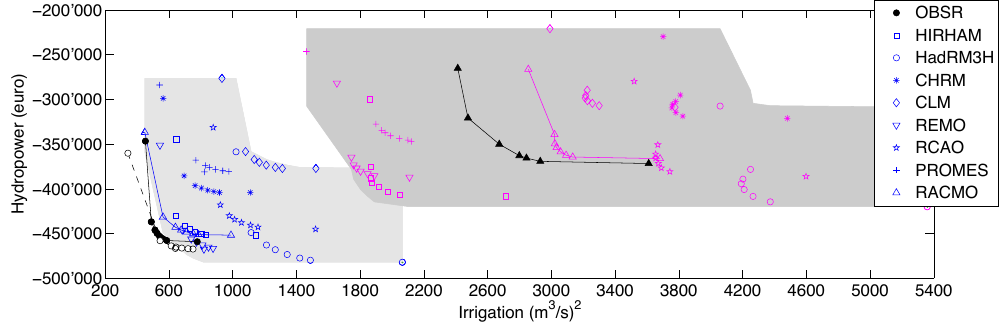
Fig. 8. IPF under historical inflow 1967–1980 (black dots), IPF under historical inflow scenario 1967–1980 (white dots), IPFs under backcast inflow scenarios (1961–1990) using eight different RCM models (blue symbols), IPFs under forecast inflow scenarios (2071–2100) with the same eight different RCMs (magenta symbols), IPF under forecast RACMO inflow scenarios (2071–2100) using optimal management policies for future climate (black